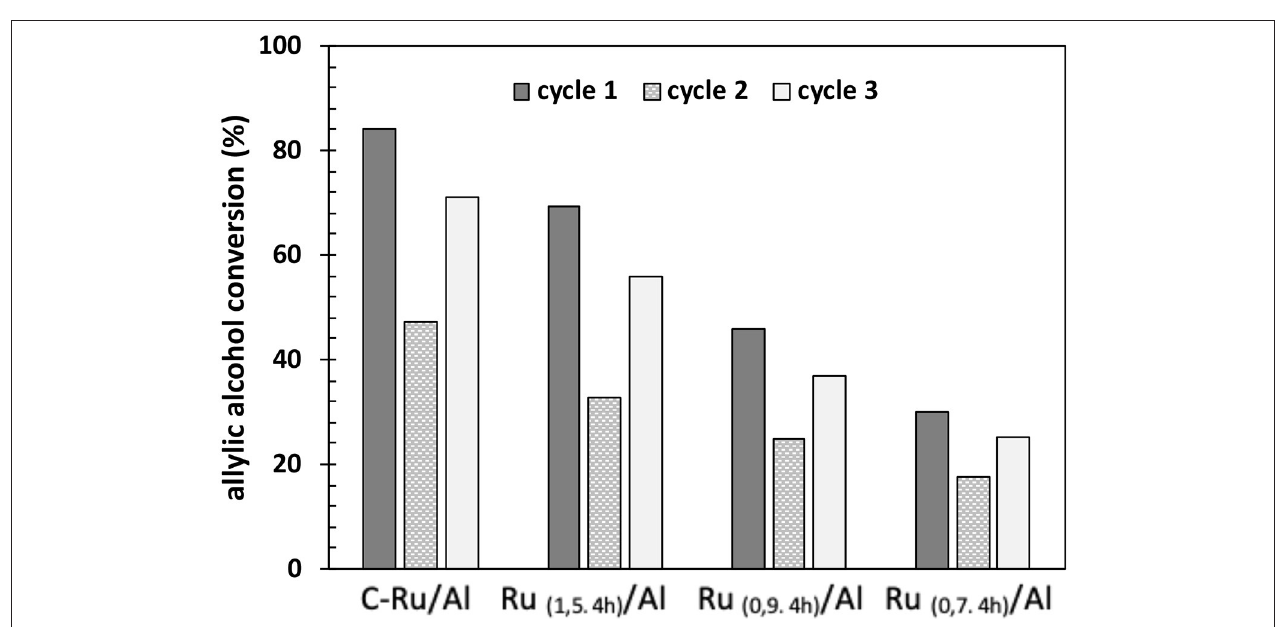
FIGURE 11 | Evaluation of the stability of the catalysts based on Ru/Al, after reuse, followed by a reductive regeneration.